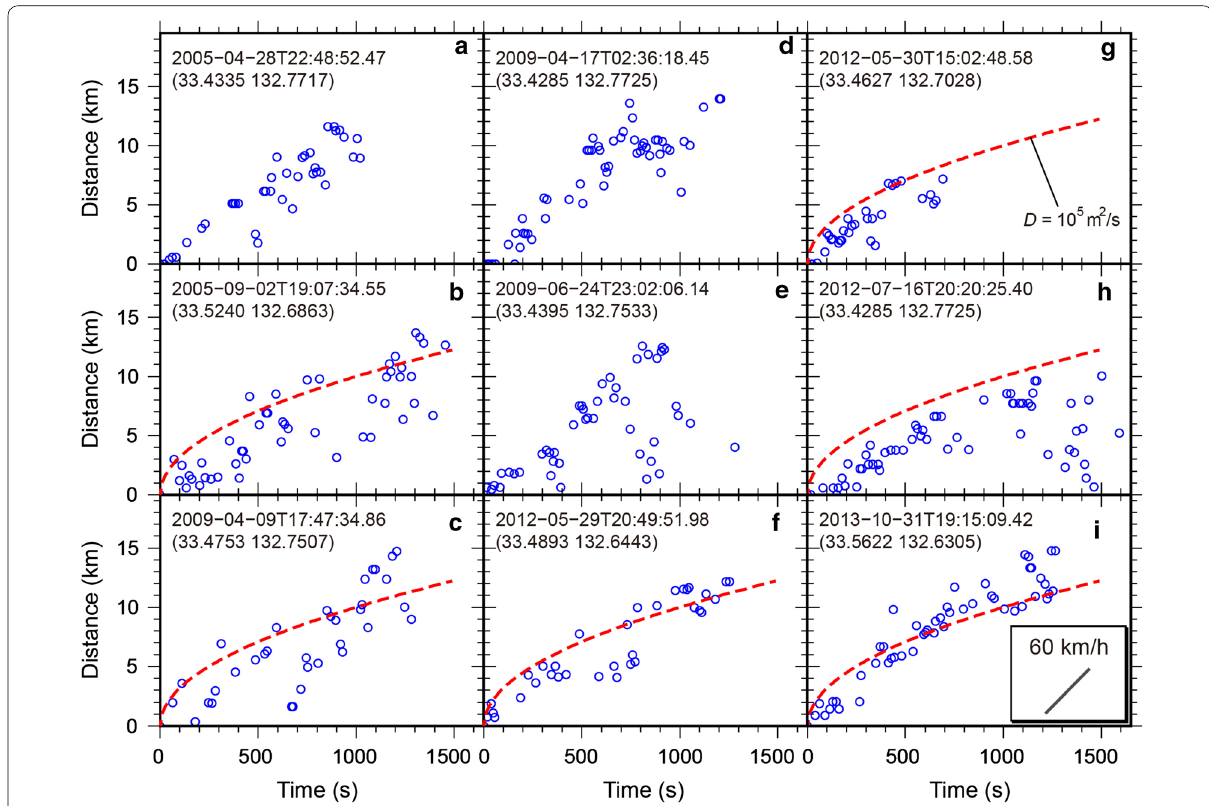
Fig. 5 Examples of rapid short-distance migration of LFEs in the western Shikoku. The vertical axis denotes distance from the initial event of each LFE burst. The dashed red curve in each panel shows a diffusional front assuming a coefficient of 10 5 m 2 /s. Time t on each plot. The latitude and longitude of the initial event are shown in